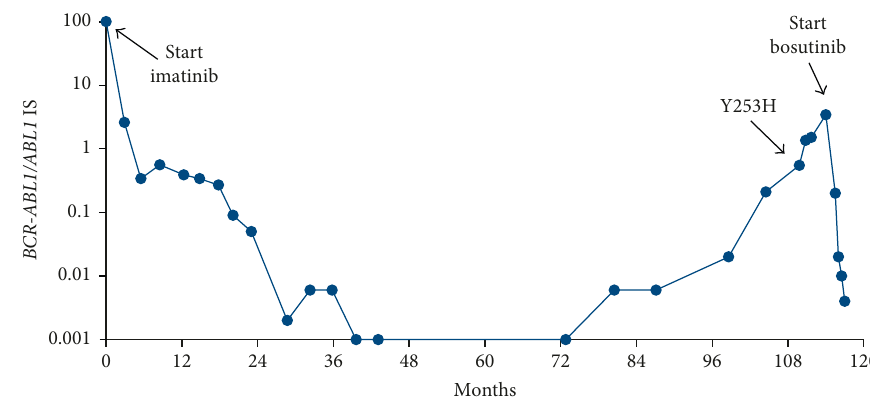
Figure 1: BCR-ABL1 transcript levels throughout clinical